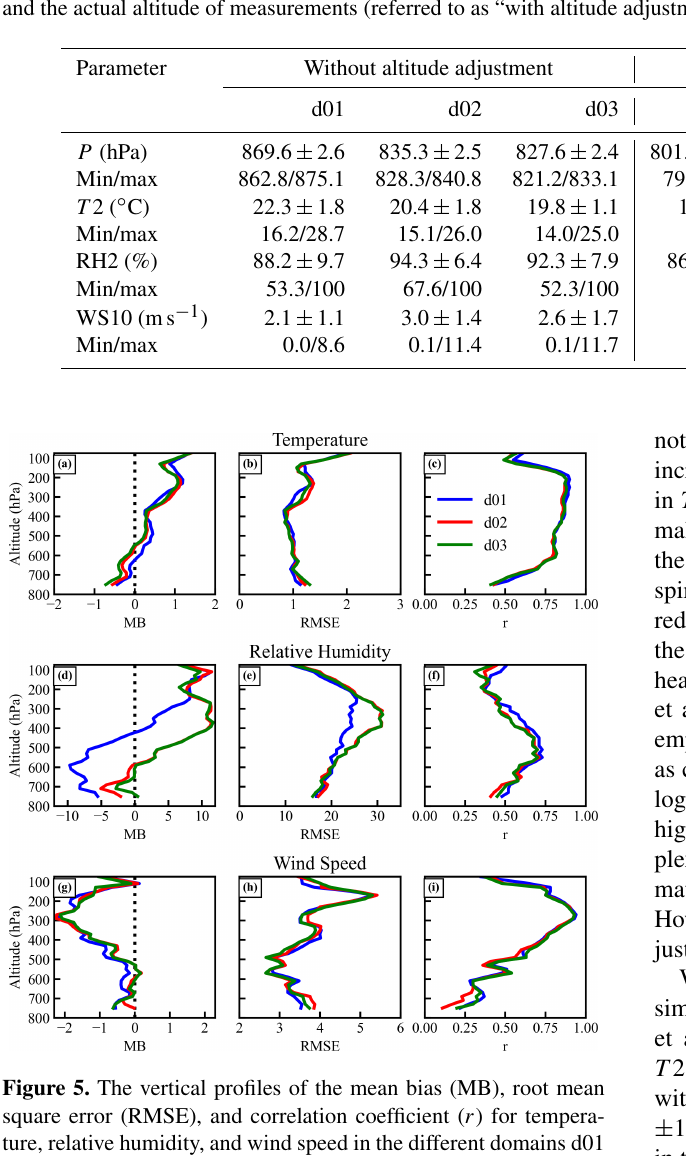
Table 1. The mean ( ± standard deviation) along with the minimum and maximum values of the meteorological parameters surface pressure ( P ; hPa), 2m temperature ( T 2; ◦ C); 2m relative humidity (RH2; %), and 10m wind speed (WS10; ms − 1 ) in the model simulations and observations for the full observation period. An additional evaluation is presented, accounting for the difference in model surface altitude and the actual altitude of measurements (referred to as “with altitude adjustment”).